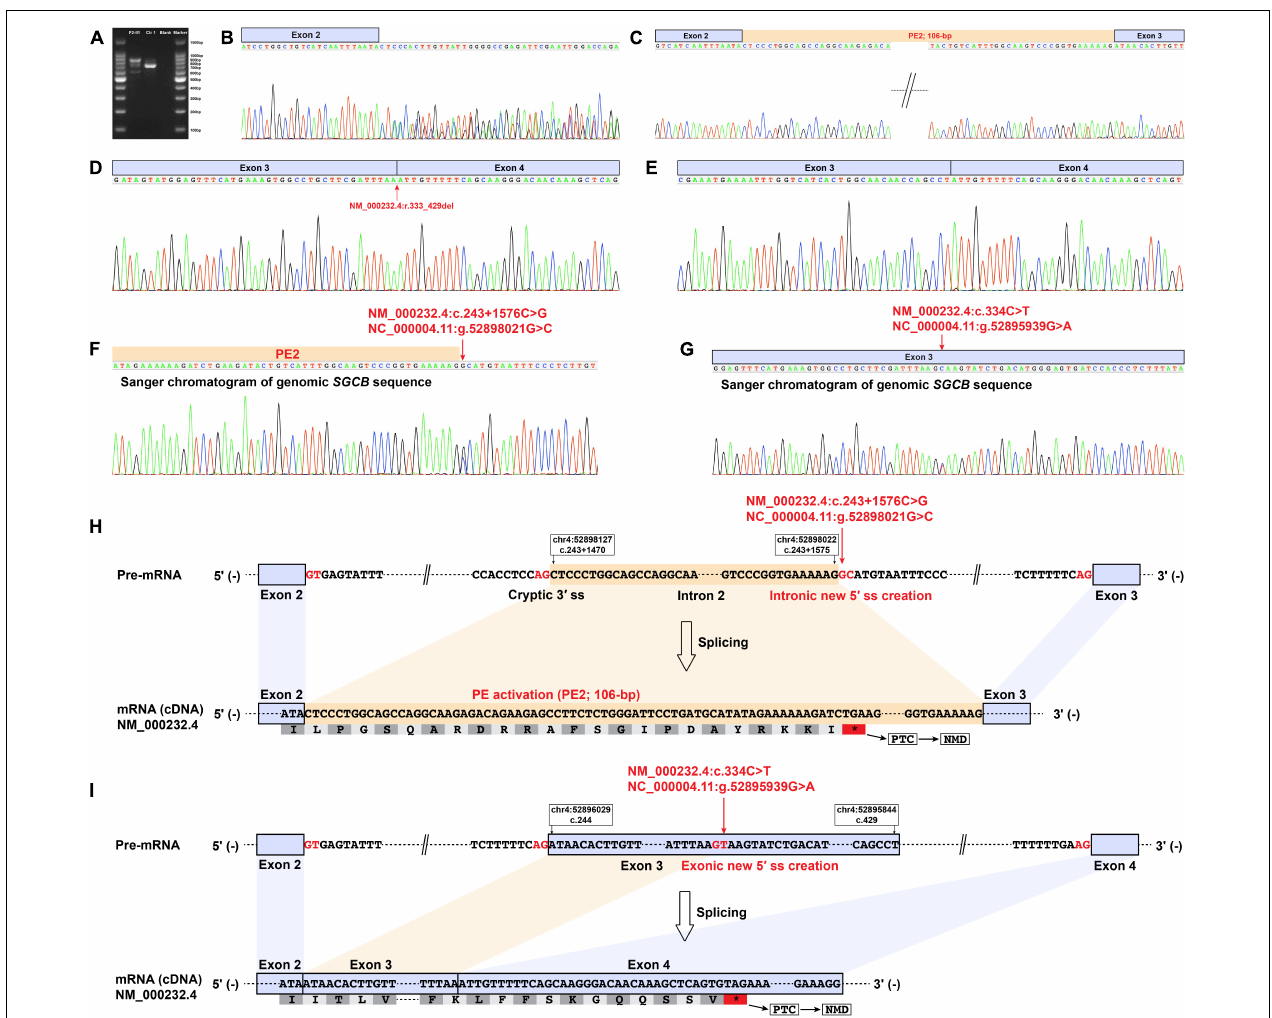
FIGURE 4 | Muscle-derived mRNA studies and genomic SGCB sequencing of patient F2-II1. (A) RT-PCR amplification of the aberrant SGCB transcripts from patient F2-II1 showed three bands with varying size. (B) Direct Sanger sequencing of the aberrant SGCB transcripts could not recognize the overlapping sequences. (C–E) TA cloning of the aberrant cDNA fragments revealed a 106-bp insertion of intron 2 sequence between SGCB exons 2 and 3 (PE2), a 97-bp truncation of SGCB exon 3, and the normal splicing of SGCB exons 3–4. (D) The Sanger chromatogram showed the beginning sequences of SGCB exon 3 and indicated the 97-bp truncation of SGCB exon 3 (NM_000232.4:r.333_429del). (F) Sanger sequencing of the genomic SGCB sequence around the PE2 revealed the c.243 + 1576C > G variant. (G) Sanger sequencing of the genomic SGCB exon 3 sequence revealed the c.334C > T variant. (H) The schematic of the aberrant 106-bp insertion of intron 2 sequence between SGCB exons 2 and 3 caused by the c.243 + 1576C > G variant in SGCB . (I) The schematic of the aberrant 97-bp truncation of SGCB exon 3 caused by the c.334C > T variant in SGCB . Ctr1, a normal control; Blank, a reagent control; PE, pseudoexon; RT-PCR, reverse transcription-polymerase chain reaction; F, fragment; bp, base pair; PTC, premature termination codon; NMD, nonsense-mediated